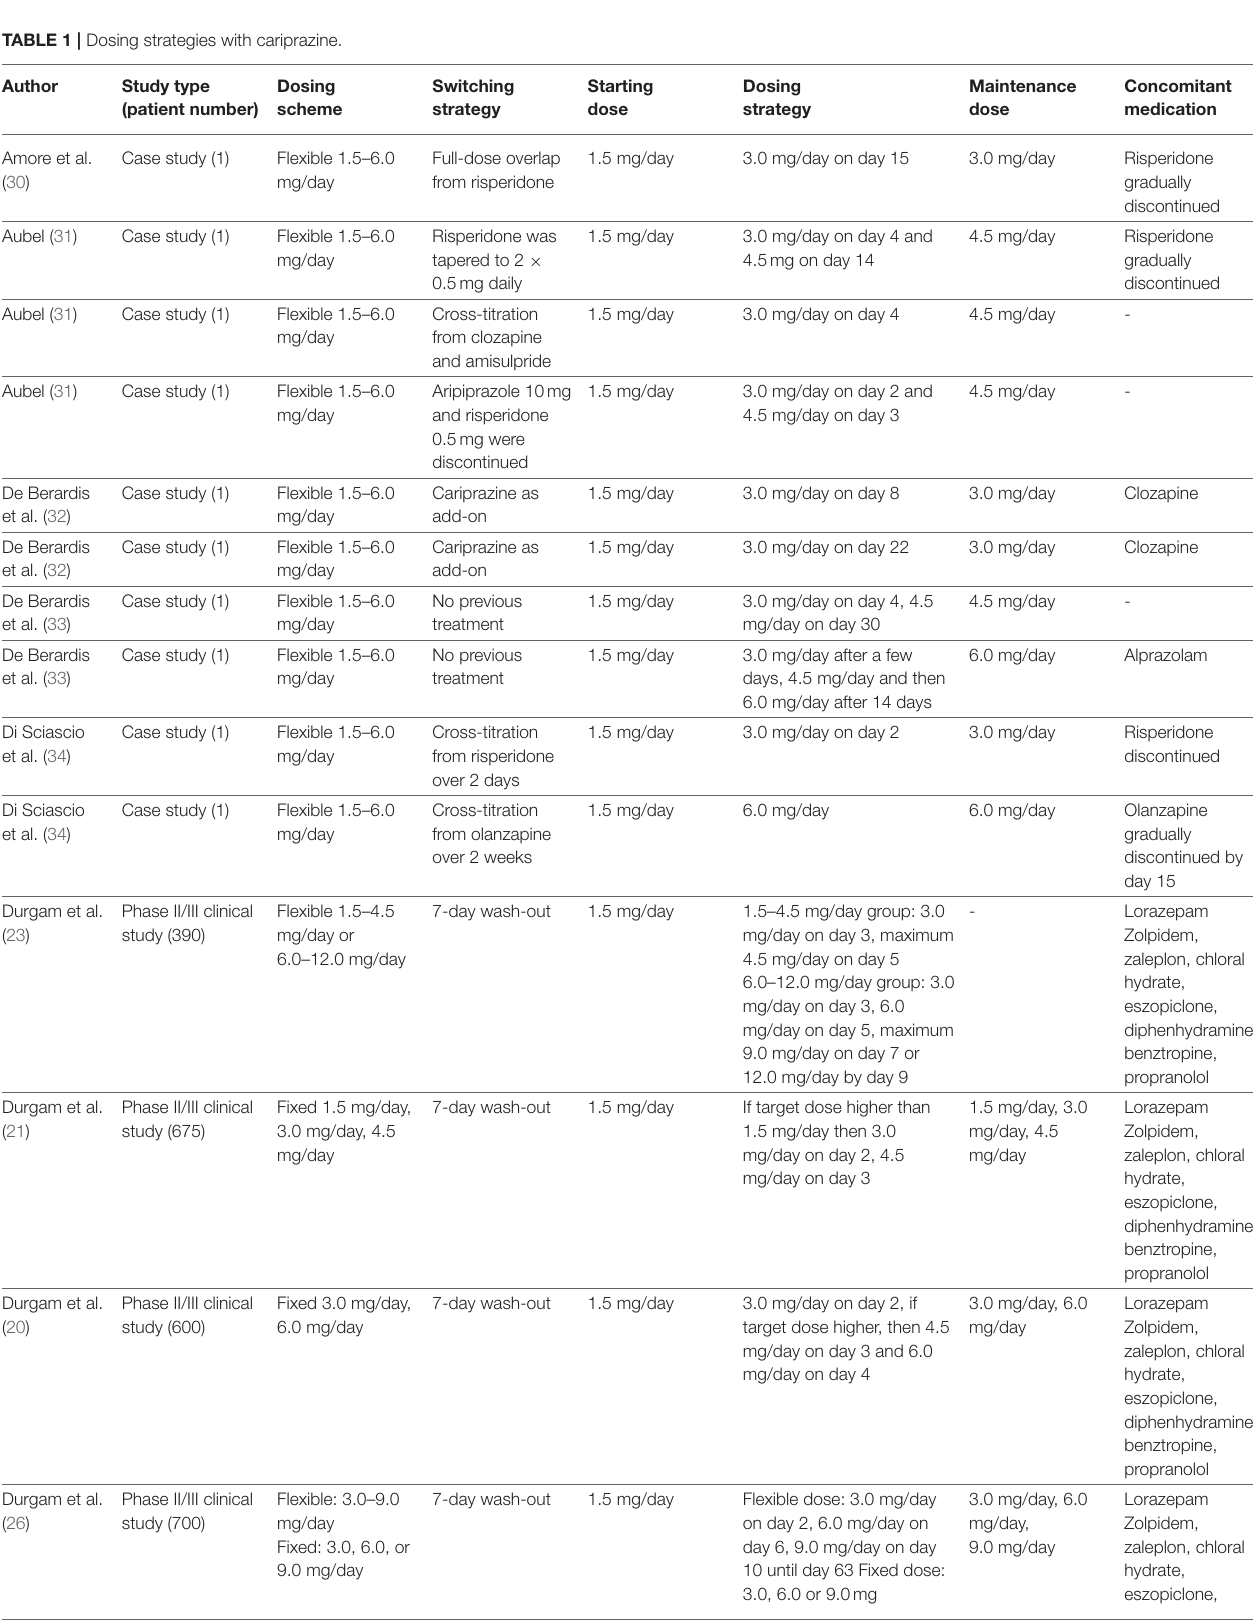
TABLE 1 | Dosing strategies with